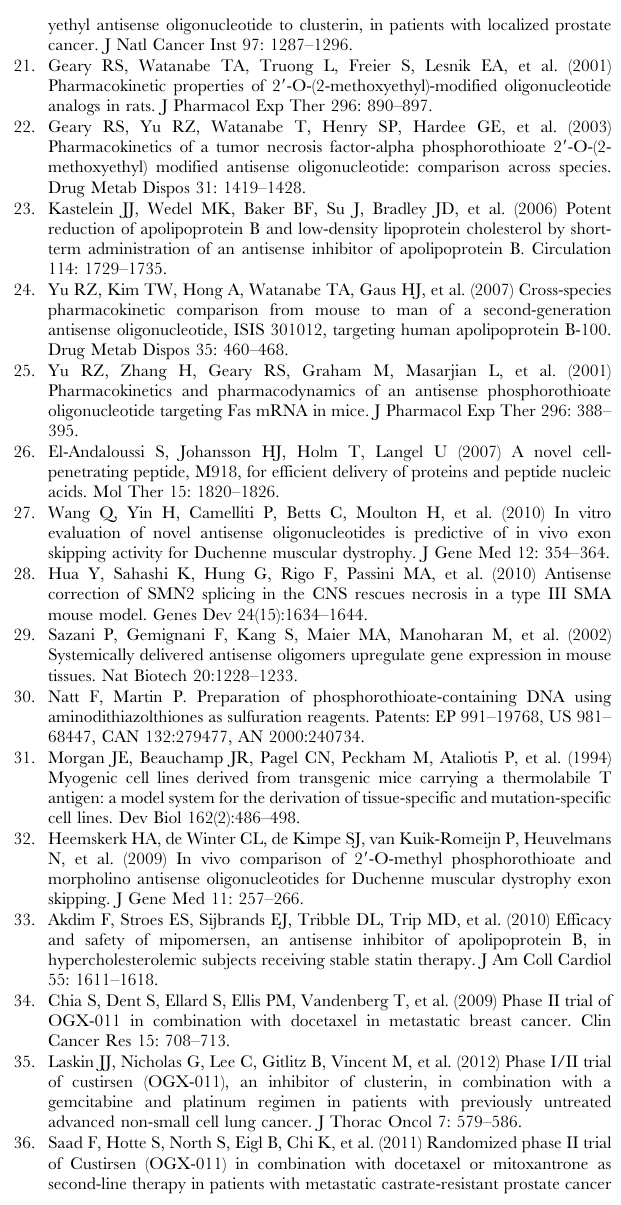
Figure S1 Comparison between MOE and 2 9 OmePS AOs in inducing exon skipping in differentiated H 2 K mdx myotubes. (A) RT-PCR results for 500 nM MOE and 2 9 OmePS AOs in differentiated H 2 K mdx myotubes at 48 h after transfection. (B) Quantification of percentage of exon 23